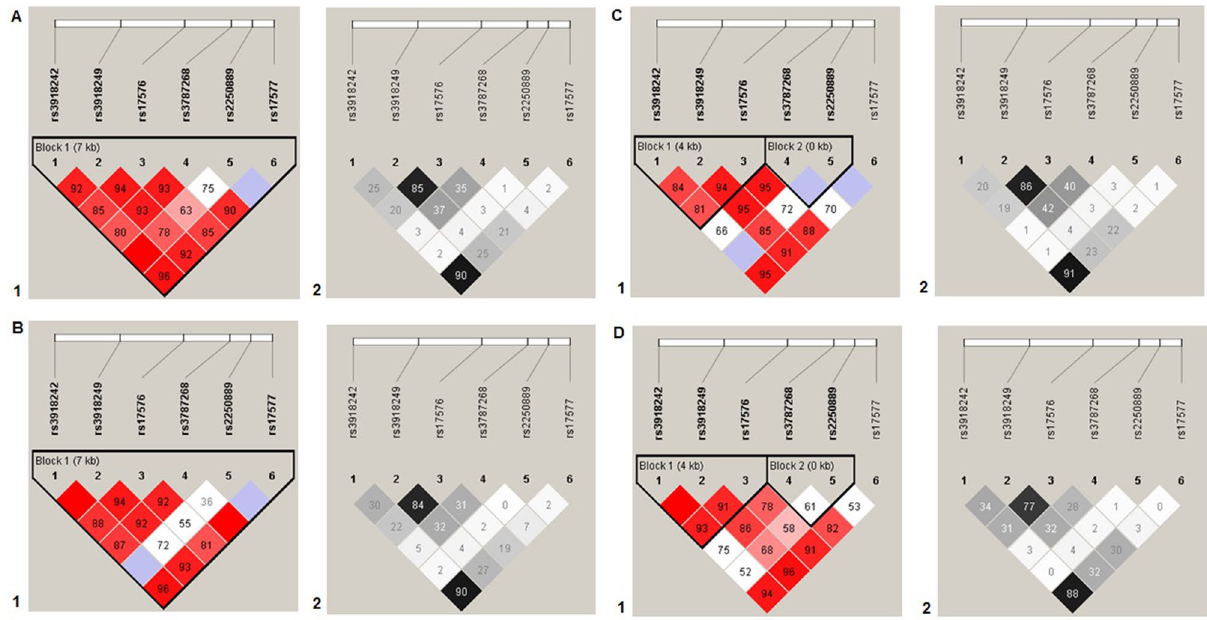
Figure 1. Linkage disequilibrium (LD) between SNPs rs3918242, rs3918249, rs17576, rs3787268, rs2250889, and rs17577 of the MMP-9 gene. ( A ) All PUD patients, ( B ) H. pylori -positive PUD patients, ( C ) H. pylori - negative PUD patients, ( D ) control group. LD values are presented as Lewontin’s standardized coefficient D ′ (Figure Sects. 1) and the square of the correlation Pearson’s coefficient (r 2 ) (Figure Sects. 2) between the